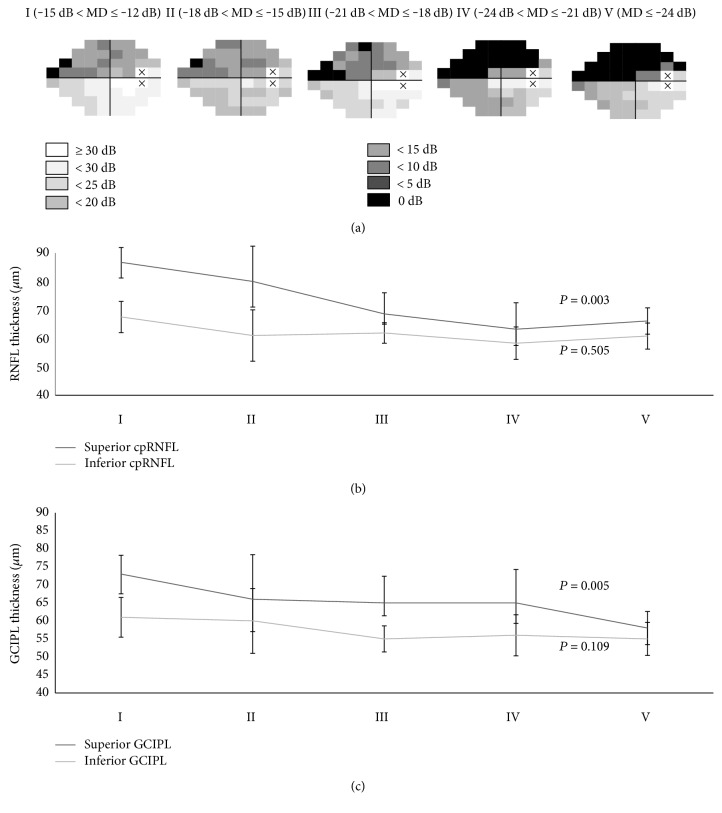
Average threshold sensitivity maps of the advance glaucoma subgroups (I to V) in cross-sectional analysis. The grayscale applied is shown on the top left. With increasing disease severity, the deepening and enlargement of scotomas occurred more frequently in superior hemifield. The scotomas in both hemifields spread toward the physiologic blind spot and toward the nasal periphery in an arcuate pattern. The scotomas in superior hemifield occurred very closely to the area corresponding to the papillomacular bundle, whereas the parafoveal area of inferior hemifield was relatively spared (a). With the disease severity (I to V), superior RNFL and superior GCIPL thickness became significantly thinner (P = 0.003 and 0.005, resp.), whereas changes of inferior RNFL and inferior GCIPL were not significant (P = 0.505 and 0.109, resp.) (b and c). “X” indicates blind spot; dB = decibel.